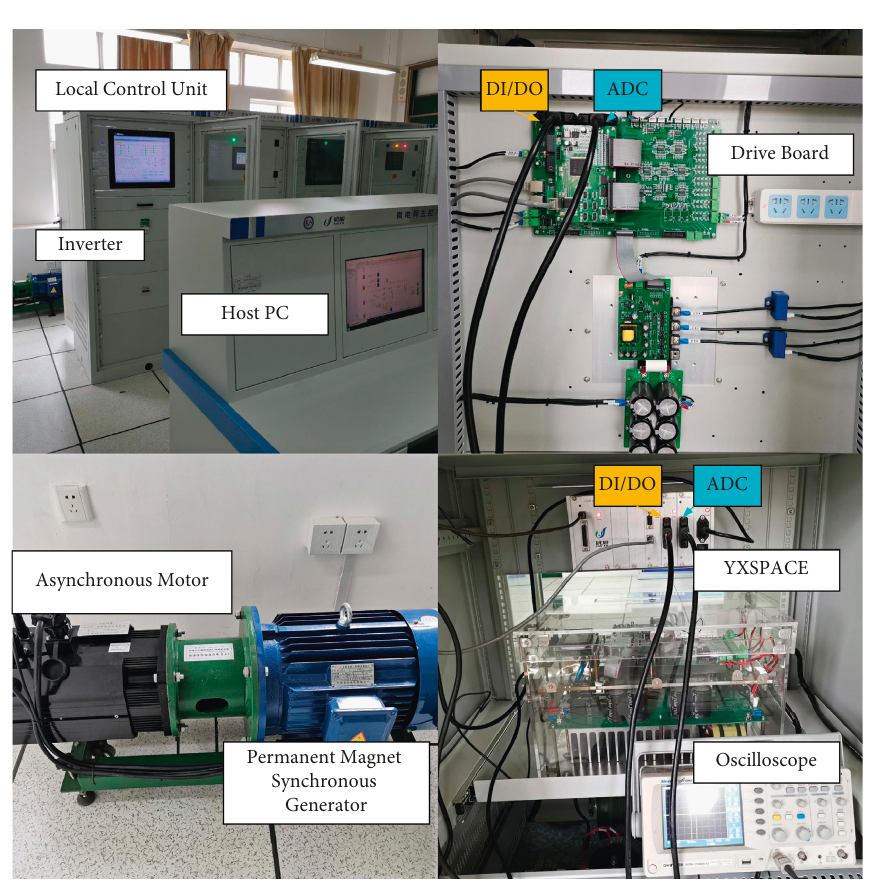
Figure 21: Experiment platform. Table 2: Key parameters of PMSG and